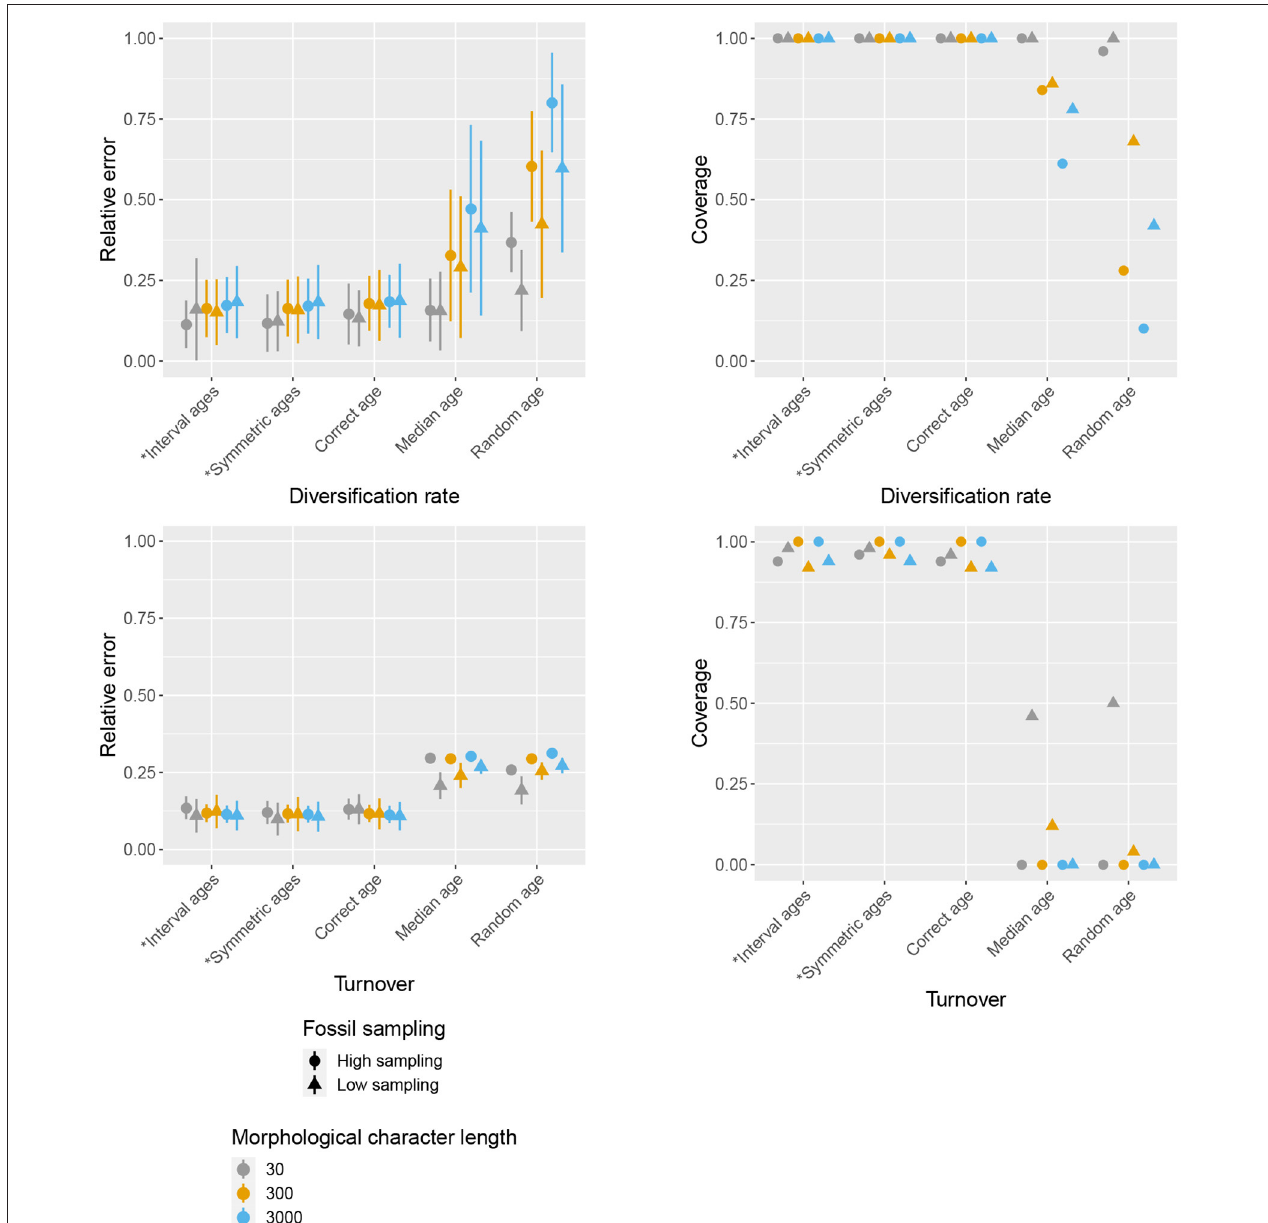
FIGURE 4 | Impact of character and fossil sampling on diversification and turnover. The mean and standard deviation of the relative error of median posterior estimates (left) , and the mean 95 % HPD coverage (right) are shown for different age handling methods, different character sampling and different fossil sampling settings. Ages sampled as part of the MCMC are marked by